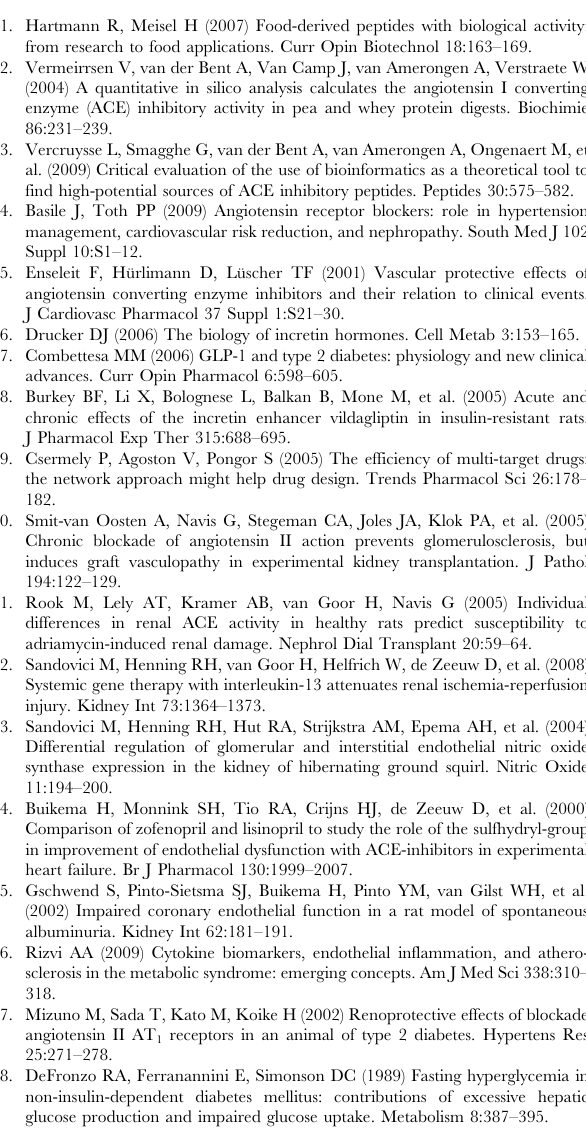
Table S1 Primers used for real-time